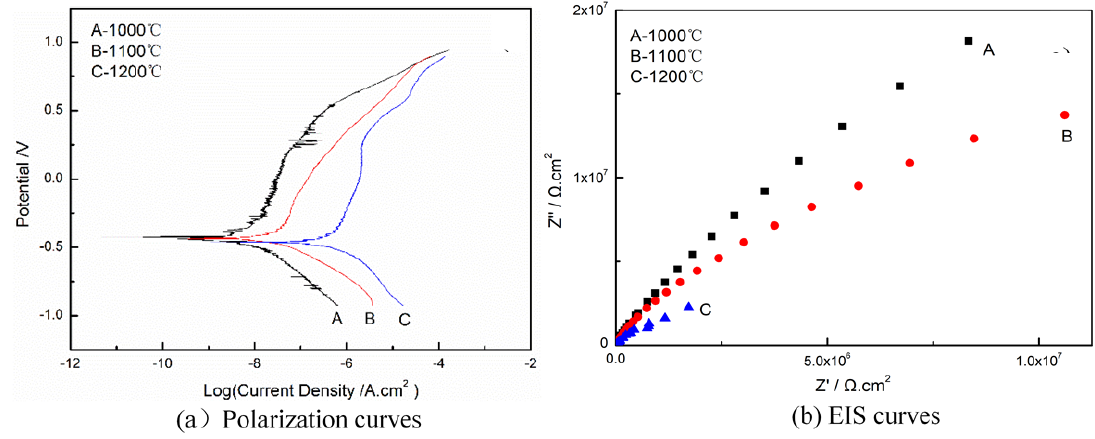
Figure 5. Polarization and EIS curves of CoNiCrMo alloy at different solution temperature.